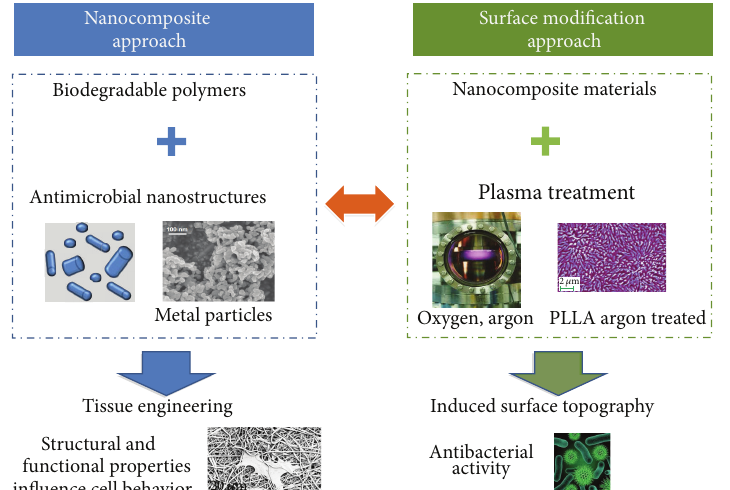
Figure 1: Schematic view of the two approaches applied in our laboratory to develop engineered nanostructured polymeric materials for anti- bacterial